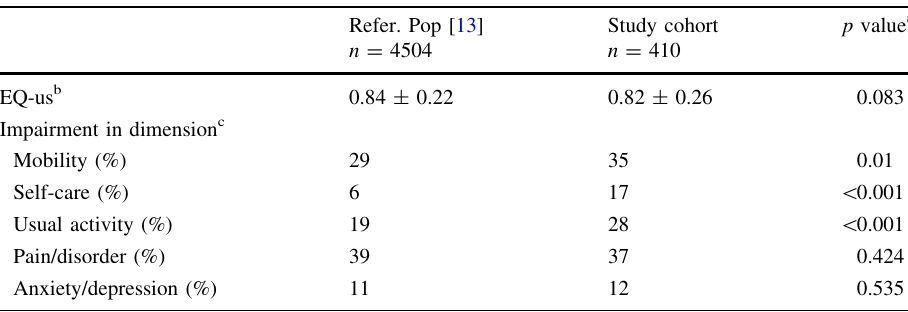
Table 4 Quality of life outcome comparison between the Dutch reference population and our study cohort, and subdivided by patients younger or equal to 65 and older than 65 years of age at the time of